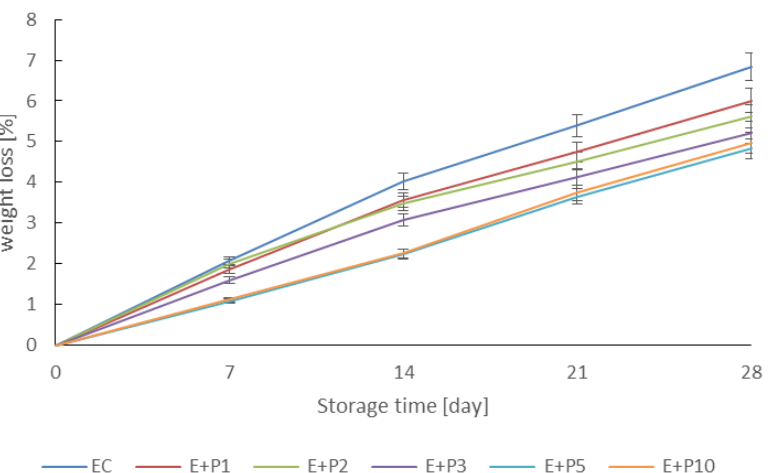
Figure 2. Changes in weight loss of hen eggs coated with propolis extract during 28 storage days. Treatments: EC — control hen eggs, E + P1 – E + P10 coated hen eggs with ethanol propolis extract at concentrations of 1 – 10%.